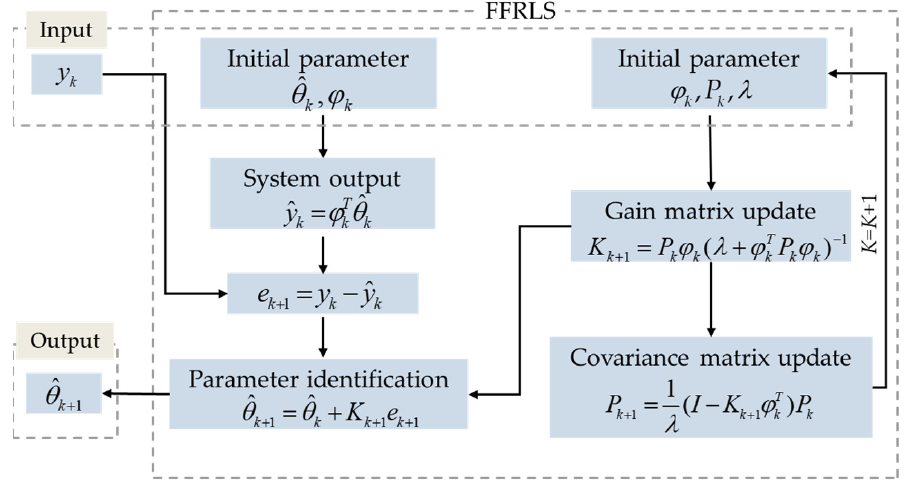
Figure 3. Process diagram of the FFRLS online identification of the OCV.